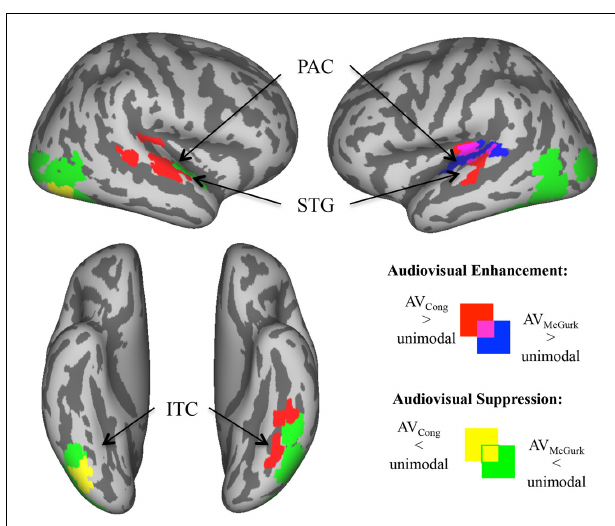
FIGURE 3 | Enhanced and suppressed activity of sensory cortex by congruentAV and McGurk speech. In analyses restricted to auditory and visual cortex (via functionally defined masks), voxels exhibiting significantly greater/enhanced or lesser/suppressed activity in AV blocks of trials as compared to A O blocks of trials (in auditory cortex) orV O blocks of trials (in visual cortex) are displayed on inflated template cortical surfaces ( p corr < 0.01). AV Cong speech (red) compared to unimodal speech had greater fMRI signal in bilateral PAC and mid-STG, and in left ITC including the fusiform gyrus. AV McGurk speech (blue) compared to unimodal speech had greater fMRI signal limited to left PAC and pSTG. By contrast, there were regions of sensory cortex where AV speech had lower fMRI signal compared to unimodal speech. AV Cong speech (yellow) had lower fMRI signal compared to unimodal speech only in right inferior LOC/ITC, whereas during AV McGurk speech (green) stimulation this effect was widely exhibited in bilateral LOC/ITC, and in right ant- to mid-STG. Abbreviations: PAC = primary auditory cortex, ant-STG = anterior superior temporal gyrus, mid-STG = middle superior temporal gyrus, pSTG = posterior superior temporal gyrus, ITC = inferior temporal cortex, LOC = lateral occipital